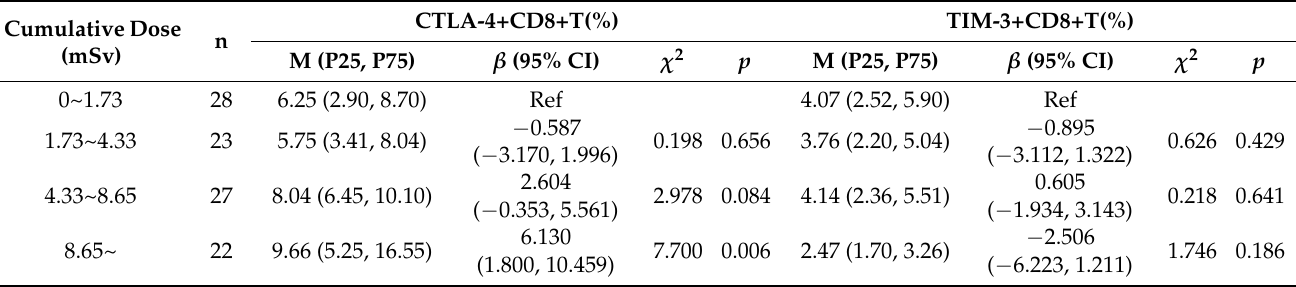
Table 7. Relationship between cumulative dose and CTLA-4 and TIM-3 expression levels in CD8+T